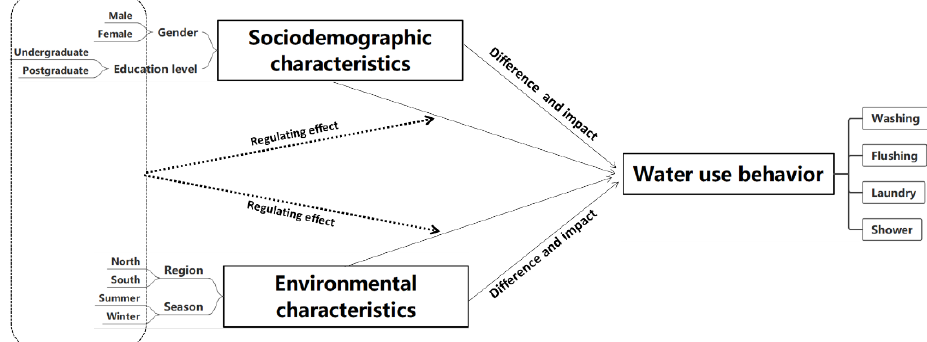
Figure 1. Analysis model framework of the influencing factors of college students’ water use behavior .